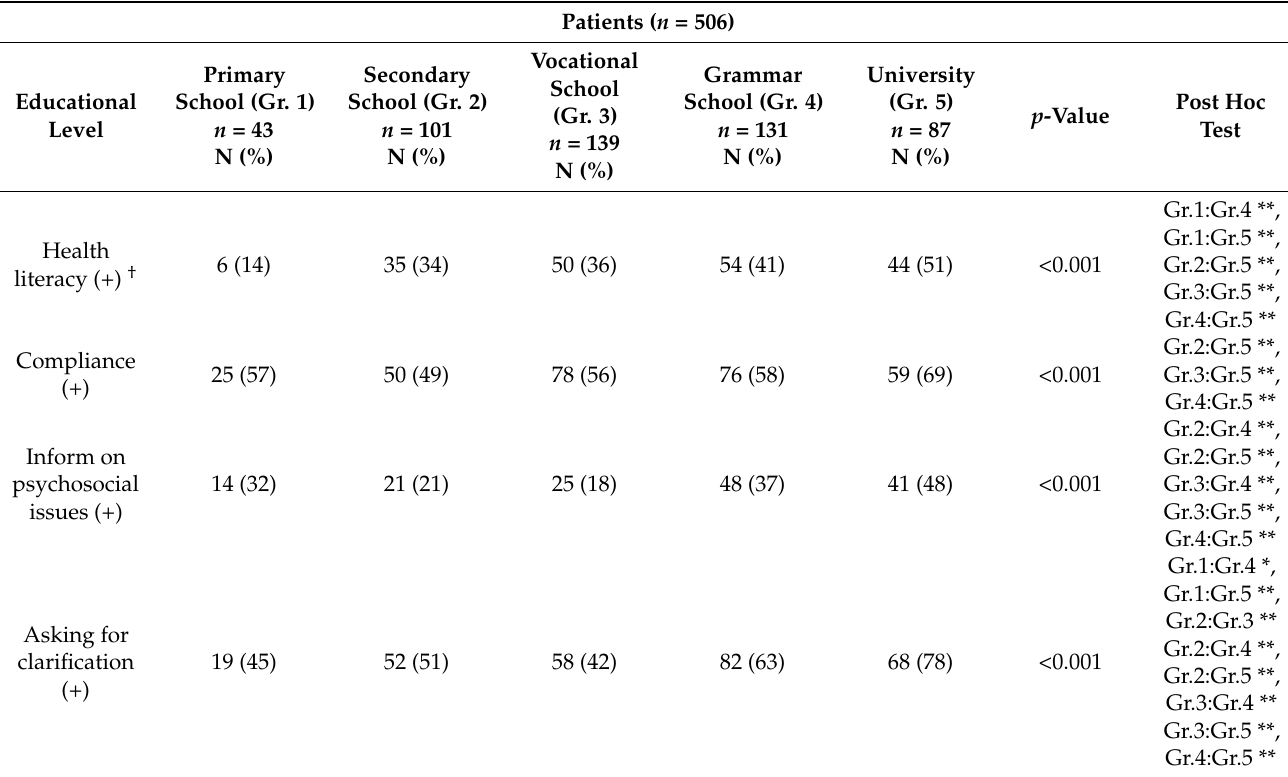
Table 4. Influence of patient’s education level on their perception of the patient’s